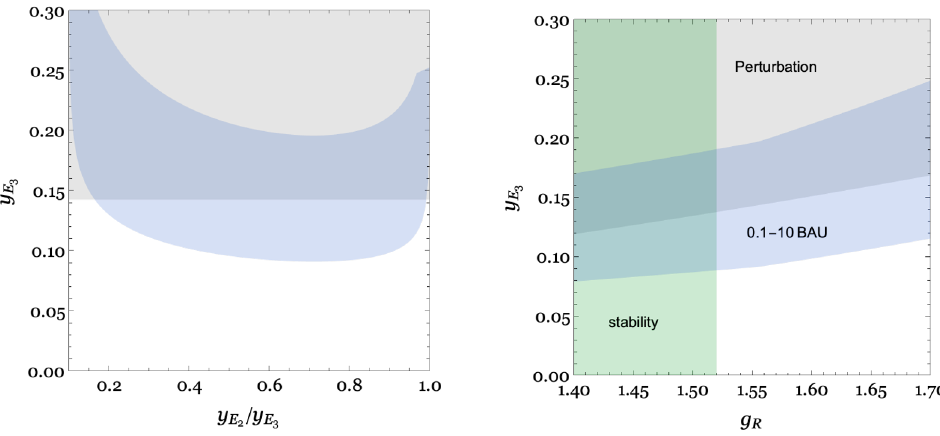
Figure 6 . The parameter region that produces 0 . 1 − 10 BAU for the extended model. In the left panel for the ( y E /y E , y E ) -plane, the model parameters are taken as g R = 1 . 55 , λ R = 0 . 014 , ˜ g E = 2 3 3 1 . 17 , J 0 = 0 . 08 , y N = 0 . 03 , y N = 0 . 89 and y N = 1 . 35 . In the right panel for the ( g R , y E ) -plane, 1 2 3 3 we take y E = 0 . 1 y E , λ R = 0 . 014 , J 0 = 0 . 08 , y N = 0 . 03 , y N = 0 . 89 , y N = 1 . 35 and v w = 0 . 48 . 1 3 1 2 3 The coupling ˜ g E is chosen in such a way that 3Ω − = l − 1 is satisfied. The gray colored region does w not satisfy the perturbative requirement, m E < 4 γ . The zero-temperature effective potential is E i not stable for φ R < 10 v R in the green colored